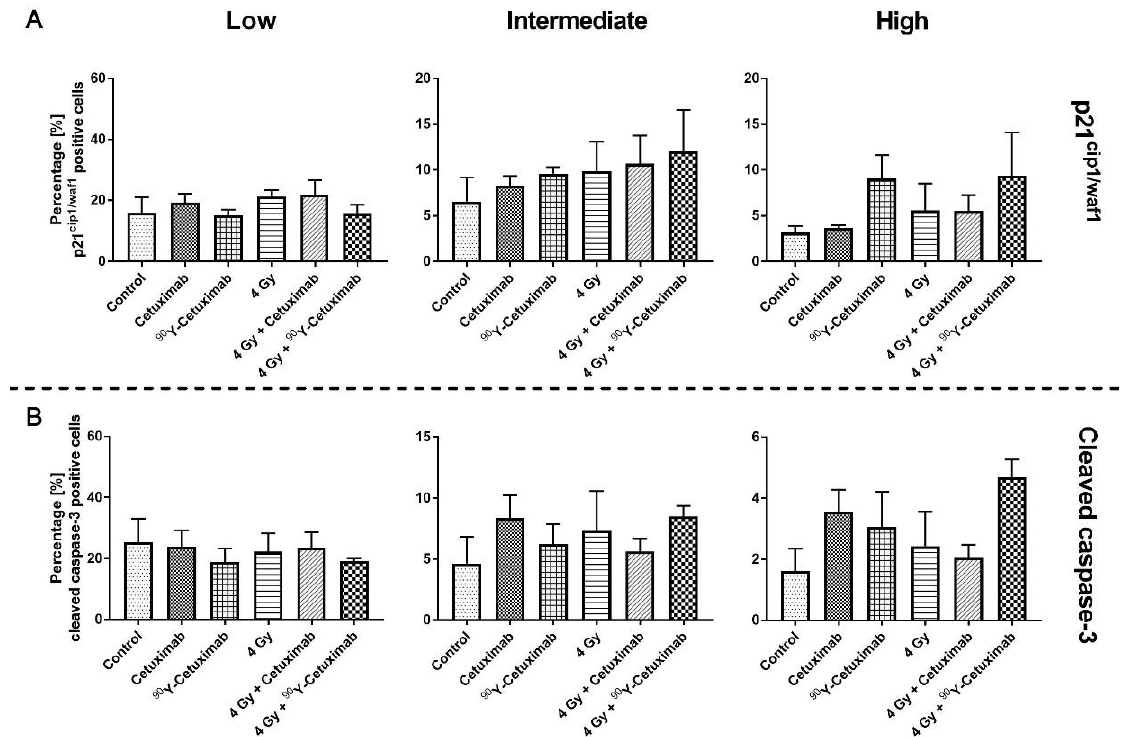
Figure 4. Analysis of p21 cip1/waf1 and cleaved caspase-3 positive cells. Whole tumor section scans of immunofluorescence staining were acquired. p21 cip1/waf1 ( n = 3, ( A )) and cleaved caspase-3 ( n = 4, ( B )) positive cells were determined. Tumor region was annotated and cells within annotation were automatically segmented. Intensity of fluorescent signal of the two markers was classified into three categories i.e., low, intermediate, and high based on the distribution of mean intensity (see Supplementary Method). Percentage of positive cells and total cell number were determined. Bars and error bars represent mean and standard error of mean, respectively.